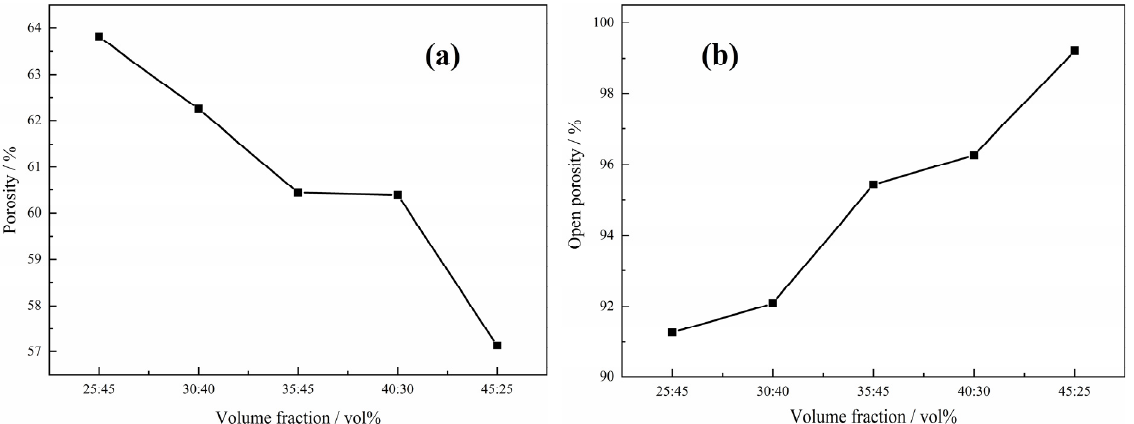
Figure 14. Relationship between porosity ( a ), open porosity ( b ) and the volume of the magnesium powders in the magnesium spacer added into the green compact.